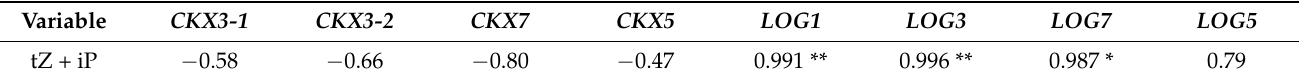
Table 3. Correlations between the concentrations of cytokinin and its metabolism-related